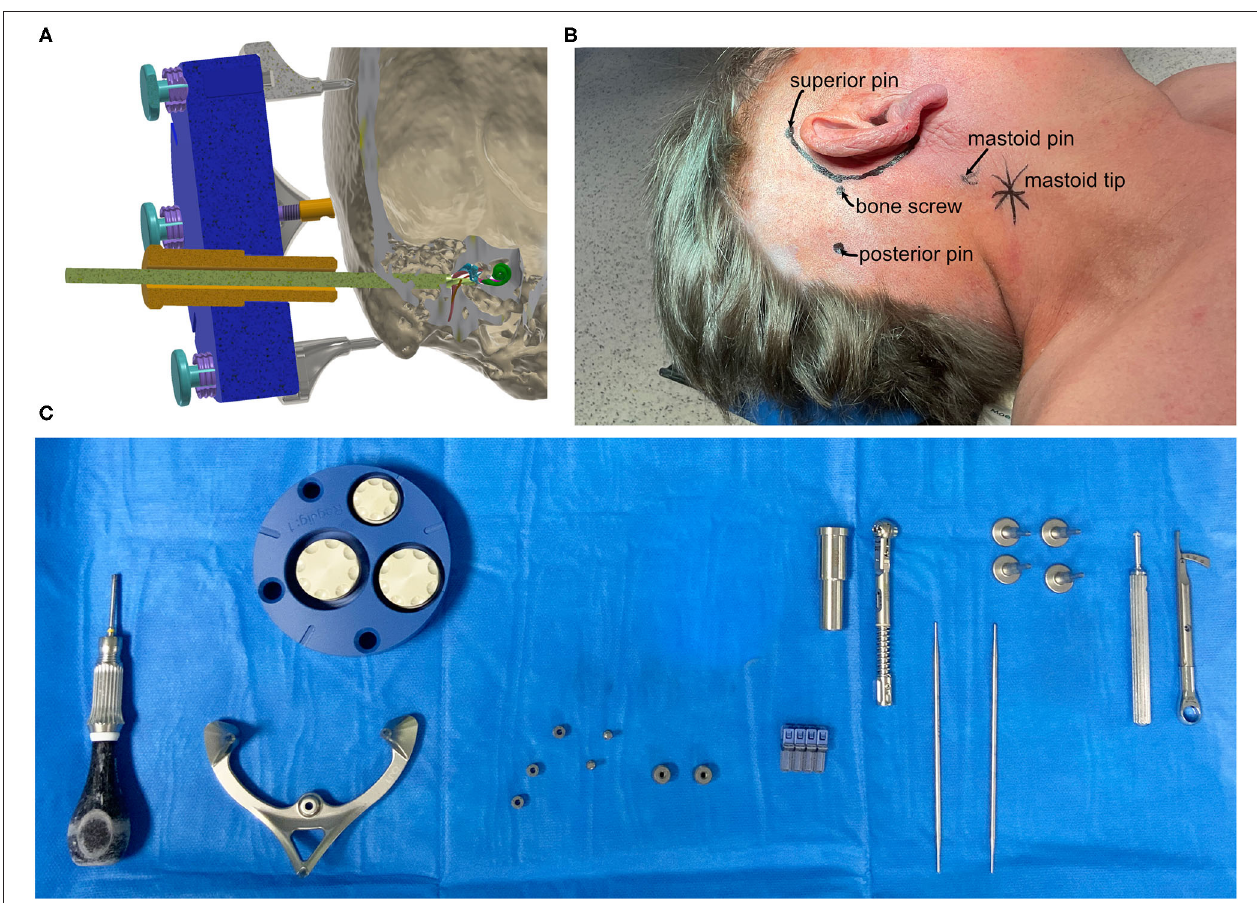
FIGURE 1 | (A) Schematic cut-plane-rendering of the proposed mini-stereotactic frame carrying a patient-specific positioning jig (blue) with a tool guide (orange) and a drill bit (green) advanced through the temporal bone toward the entry of the cochlea. The frame and the positioning jig are connected with three jig fasteners. (B) The positions of the pins of the mini-stereotactic frame and the position of the bone screw indicated on a patient (case 06). (C) From left to right, the sterilized set in the operating theater; screw driver, mini-stereotactic frame, X-ray marker, anchor, mounting screws, bone screws, tool guide, torque ratchet, and sham drill bits, jig fastener pins, screw driver, and torque